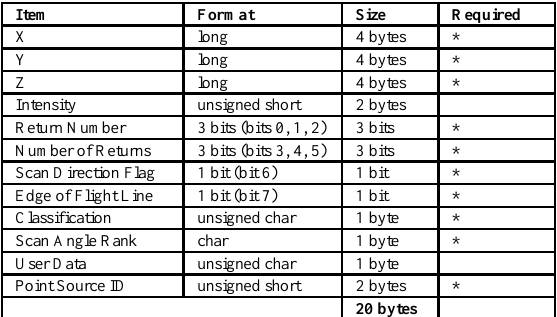
Table 1: Compact representation of a single point in the LAS file